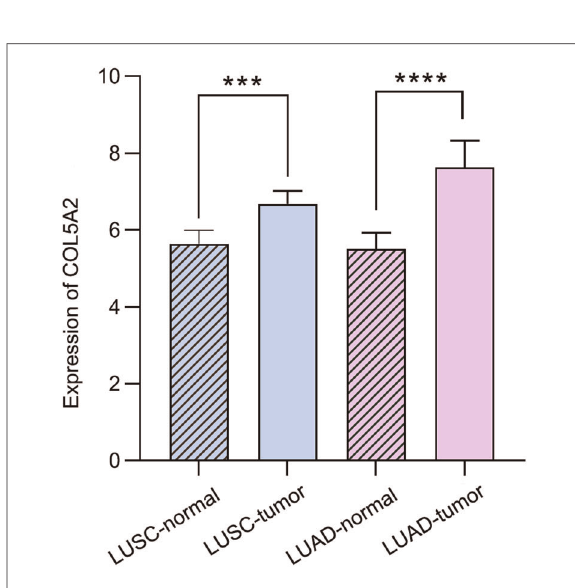
FIGURE 7 Substances related to COL5A2 . Pink and blue circles represent substances that up- and downregulate COL5A2